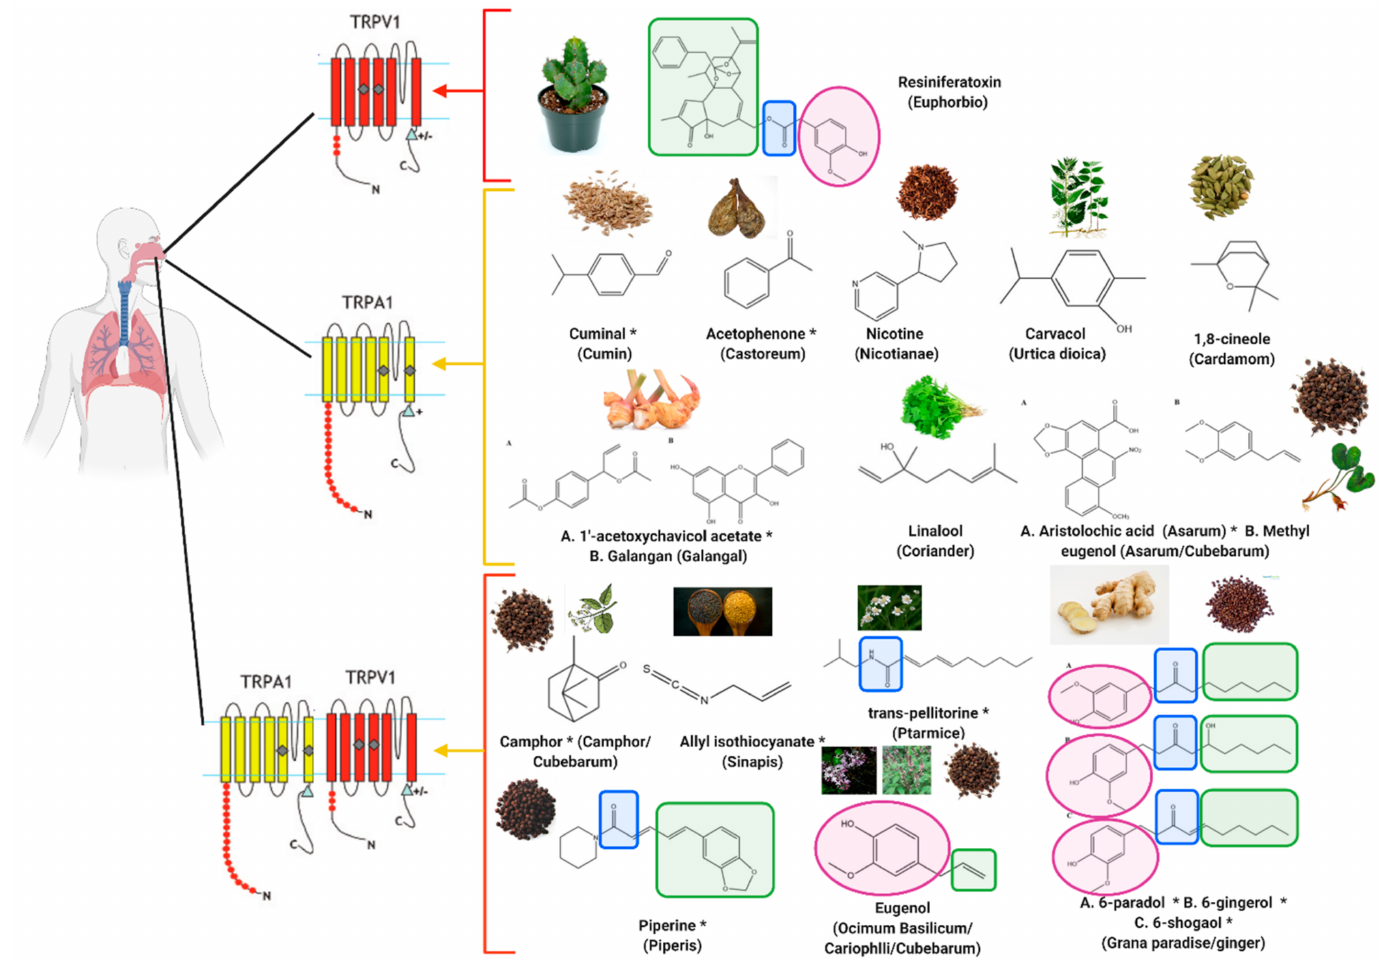
Figure 9. Agonists of TRPA1 and TRPV1 reported to induce sneezing over centuries (pink shape indicates vanillyl group, blue shape indicates polar entity (instead of amide group), green shape indicates aliphatic group); * represents electrophilic compounds activating TRPA1 via the reported or suggested covalent modification of the cysteine residues of the intracellular N -terminal. Generated by Biorender.com (accessed on 15 February